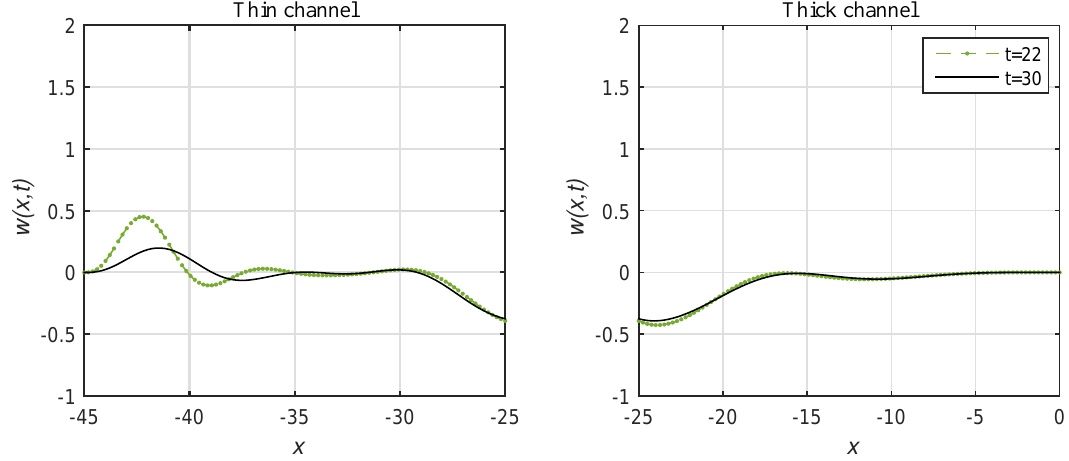
Figure 10. Continuation from Figure 9. t =